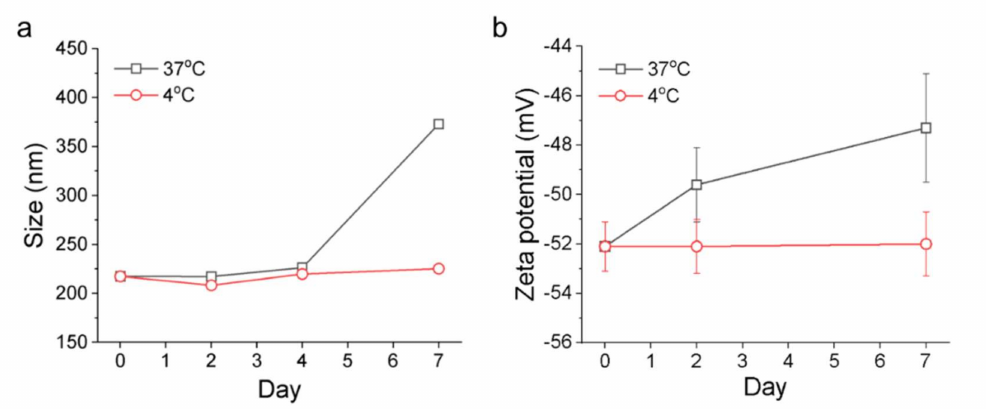
Figure 4. Monitoring the stability of FuNPs in PBS by size ( a ) and zeta potential ( b ) using DLS from day 0 (as synthesis) to day 7.